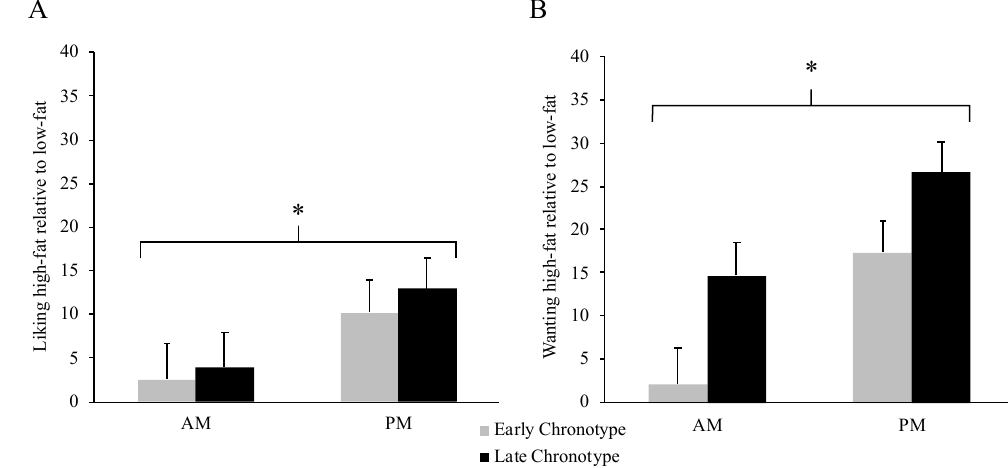
Figure 3. Liking ( A ) and wanting ( B ) scores (pre-post meal scores collapsed) for high-fat relative to low-fat foods according to meal timing condition (AM vs. PM) and chronotype (Early vs. Late). * Main e ff ect of meal timing condition, p ≤ 0.004. N = 36 (Early Chronotype N = 17, Late Chronotype N = 19). Data are mean ±